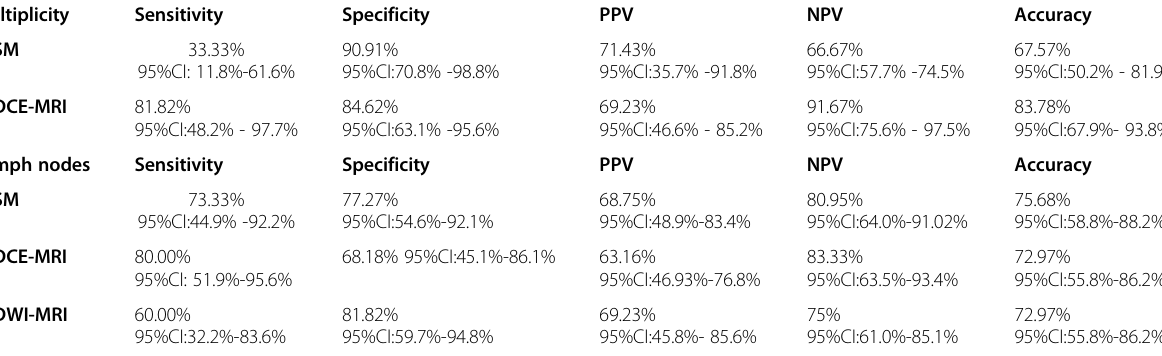
Table 3 Comparison of diagnostic indices of Sonomammography, DCE-MRI and DWI-MRI regarding multiplicity and axillary lymph nodes status in the upfront surgery group